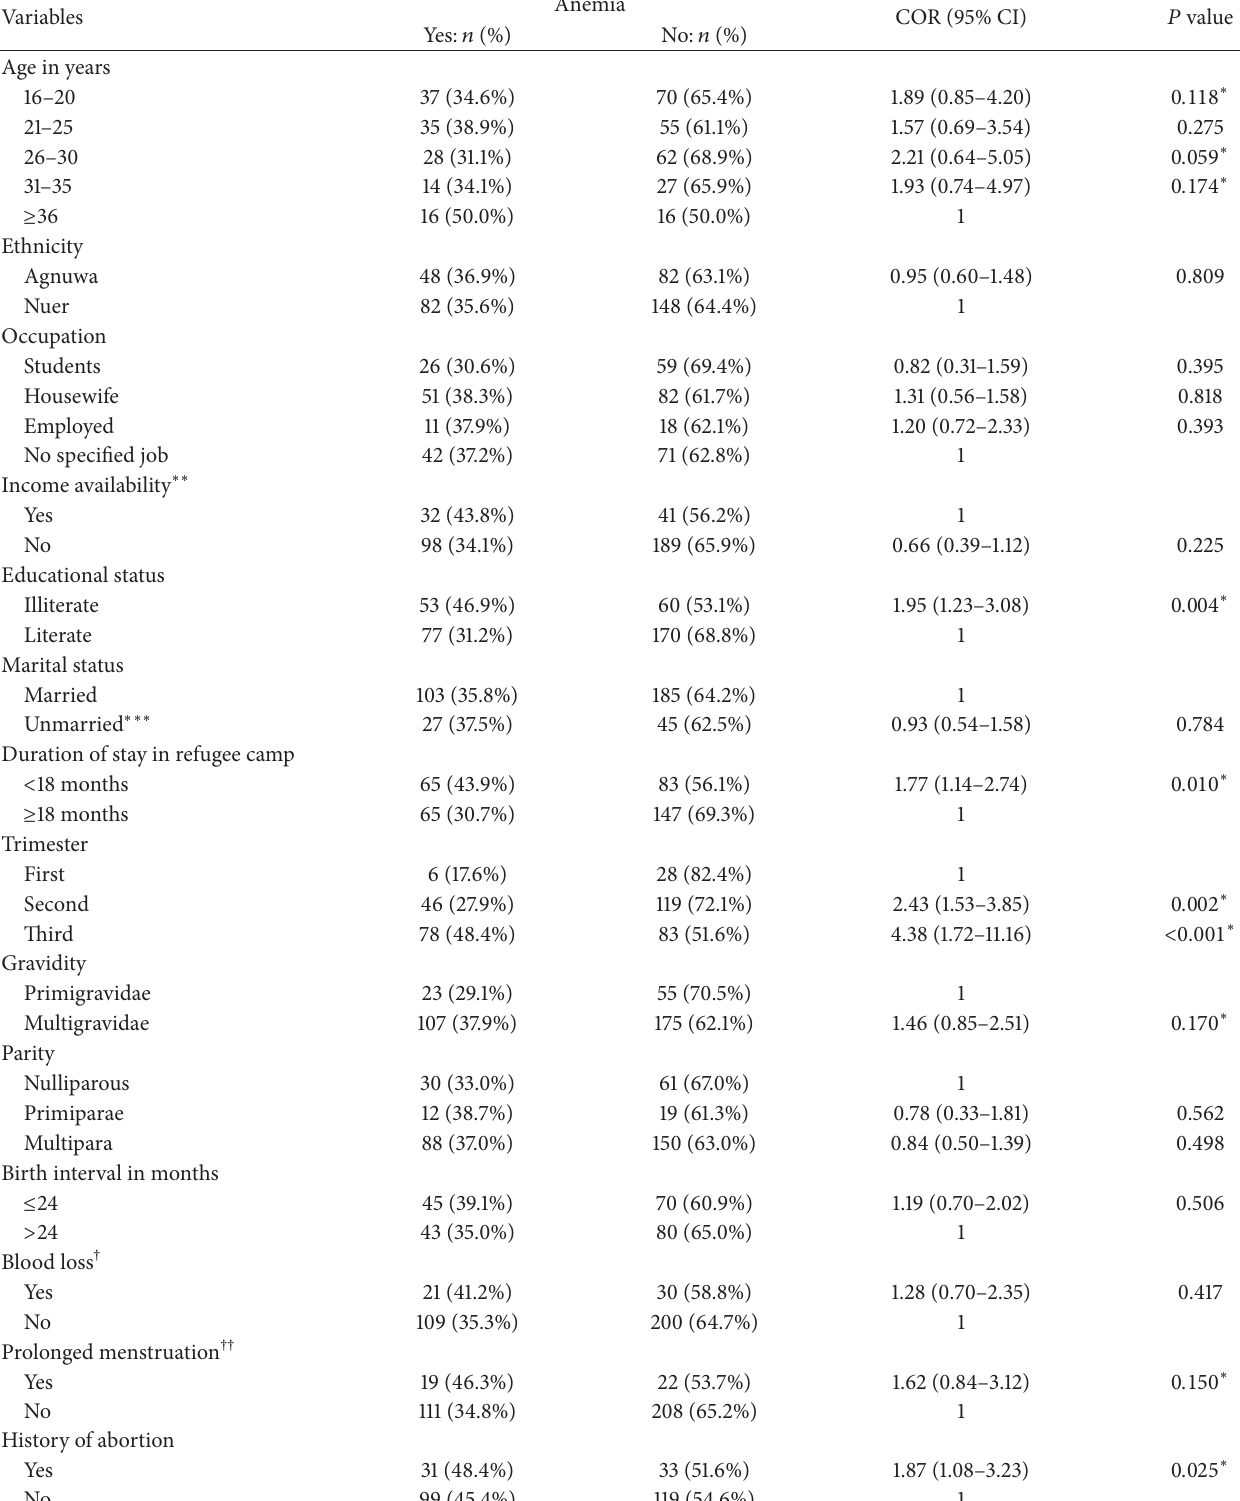
Table 2: Sociodemographic and obstetric characteristics of the refugee pregnant women attending ANC clinic at Pugnido ARRA Health Center in Gambela, Western Ethiopia, April 15–June